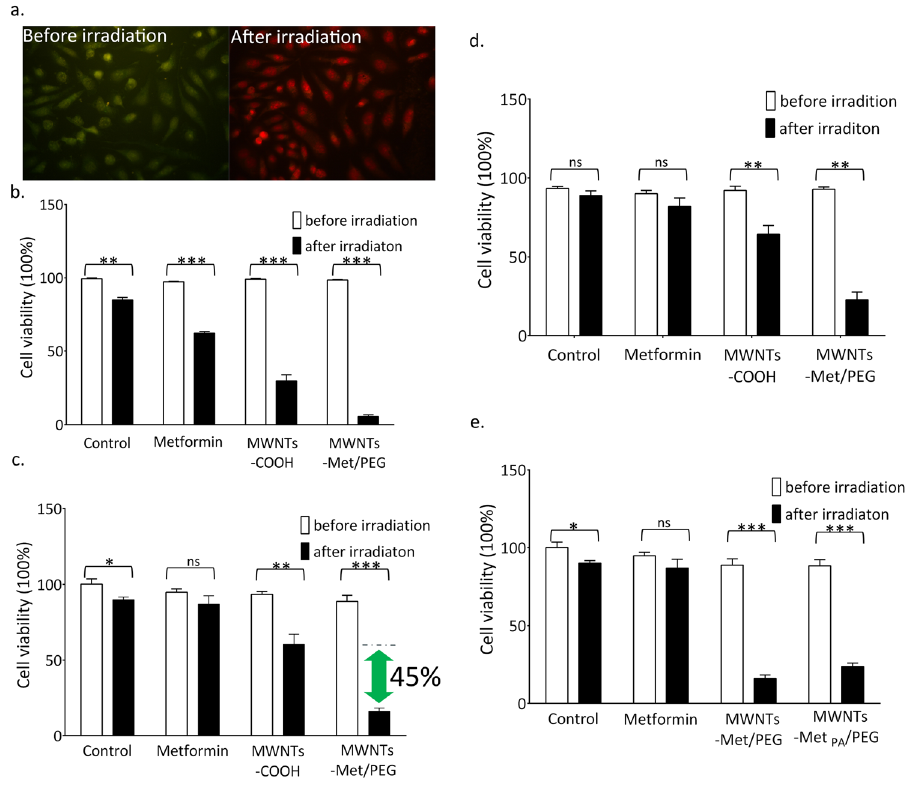
Figure 4. ( a ) Cell diagrams of HepG2 cells incubated with MWNTs-Met/PEG (left) before irradiation (right) after irradiation. The cell viabilities of HepG2 cells incubated with metformin (1 mM), MWNTs-COOH and MWNTs-Met/PEG under NIR irradiation were established via ( b ) AO/EB staining ( c ) MTT assay ( d ) Trypan blue exclusion assay. ( e ) Cytotoxicity determination via MTT assay for MWNTs-Met/PEG and MWNTs-Met PA /PEG. The MWNTs-Met/PEG contained only 35 µ M of metformin as calculated from TGA. MWNTs-Met PA / PEG had ~72% of the drug loading of MWNTs-Met/PEG (35 uM; 1.742 mmol/g: 25 uM; 1.254 mmol/g). The NIR irradiation power density was 2 W·cm − 2 (5 min) for b , and 0.8 W·cm − 2 (8 min) for c , d and e , respectively. The bars are presented as the mean ± s.e.m. (Unpaired t-test, * P < 0.05, ** P < 0.01, *** P <